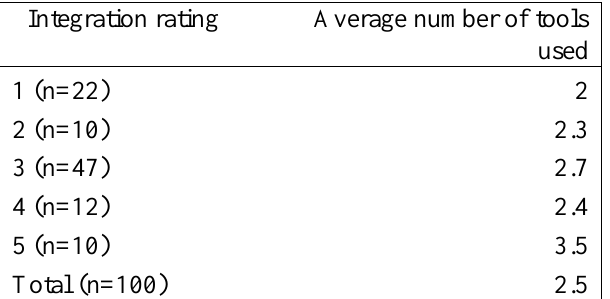
Table A4.2 . Average number of tools used by studies with different levels of integration. Likert scale from 1(minimal integration) to 5 (a great amount of integration).